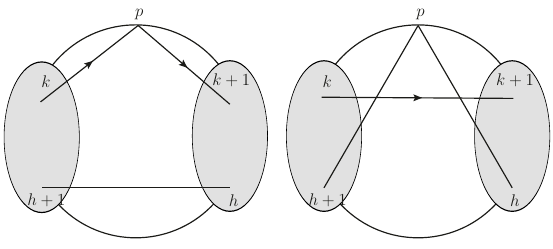
Figure 10 . Disk diagram for the case p is coupled to 1 /s